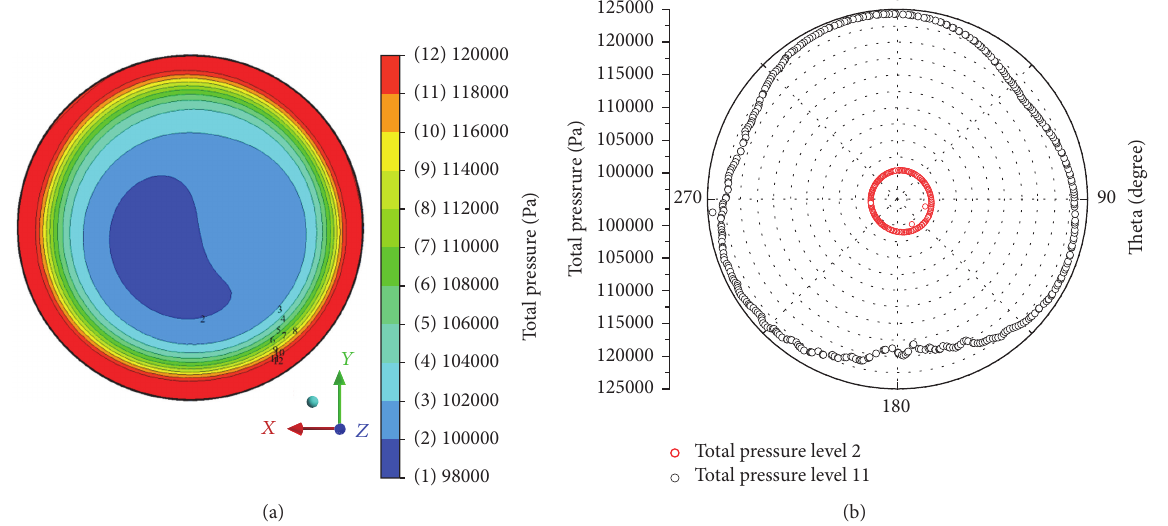
Figure 9: Distributions of the total pressure (a) and total pressure level 2 and level 11 (b) in the theta direction at 0.4 𝑄 𝑑 .